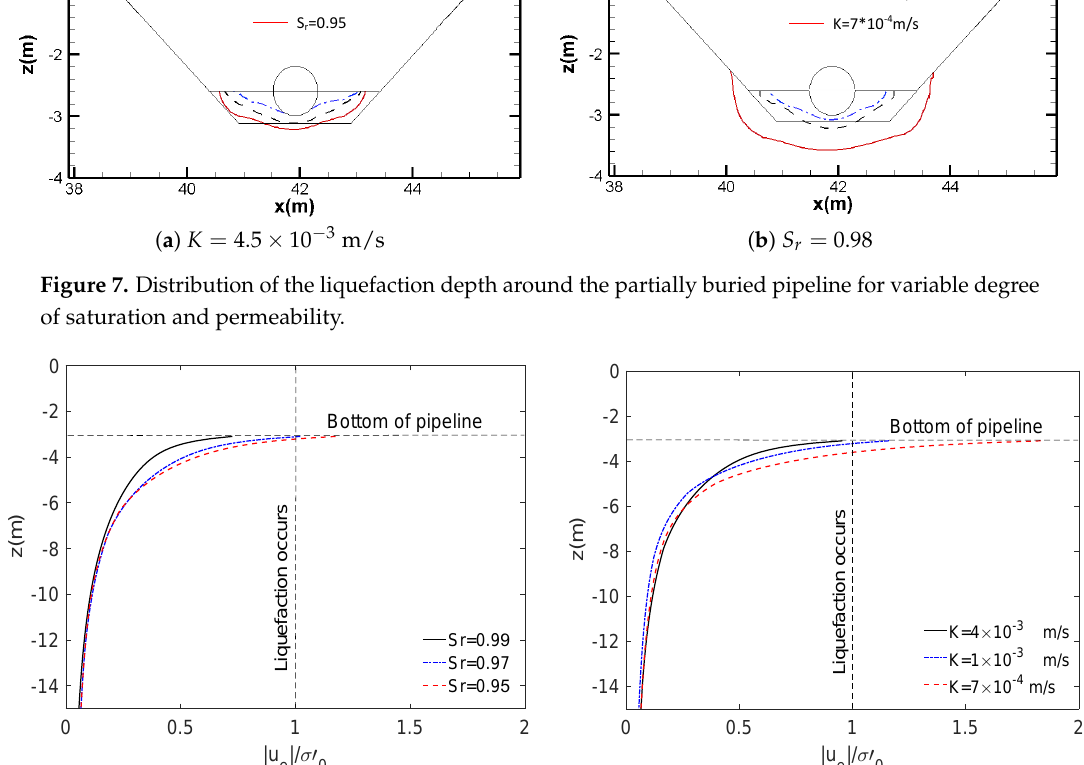
) under wave trough along the vertical 0